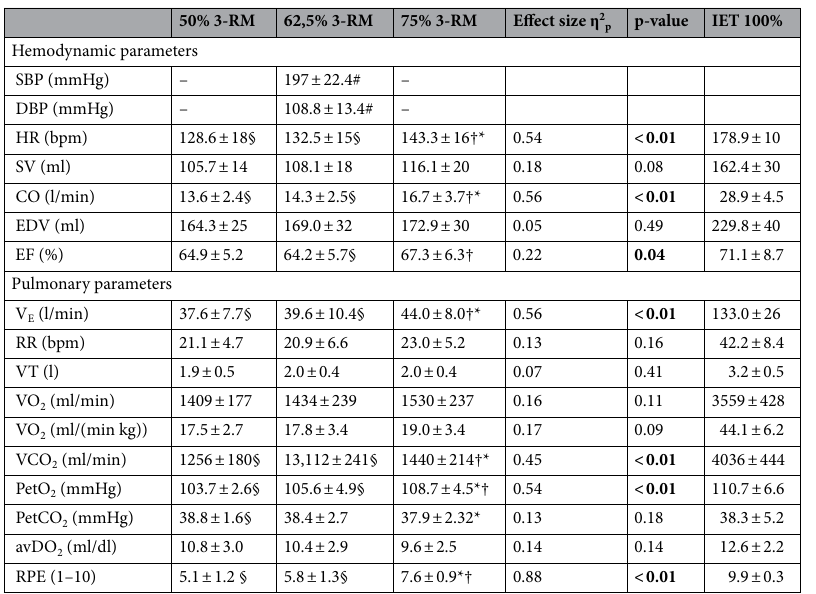
Table 2. Mean values during exercise period (n = 14; three sets of 10 repetitions, excluding warm-up and recovery phases). Significant values are in bold. Values are presented as the means and standard deviation; IET incremental exertion test (the displayed IET data were not included in the ANOVA and only for illustration), η 2 p partial eta-squared of the one way repeated measures ANOVA (50% intensity, 62.5% intensity, 75% intensity), SBP systolic blood pressure, DBP diastolic blood pressure, HR heart rate, SV stroke volume, CO cardiac output, EDV end-diastolic volume, EF ejection fraction, V E ventilation, RR respiratory rate, VT tidal volume, VO 2 oxygen uptake, VCO 2 carbon dioxide output, PetO 2 end-tidal oxygen-partial pressure, PetCO 2 end-tidal carbon dioxide partial pressure, avDO 2 arteriovenous difference, RPE rating of perceived exertion. * (P < 0.05) different from 50% intensity; † (P < 0.05) different from 62.5% intensity; § (P < 0.05) different from 75% intensity; # = (n = 12) separate measurement with 62.5% of